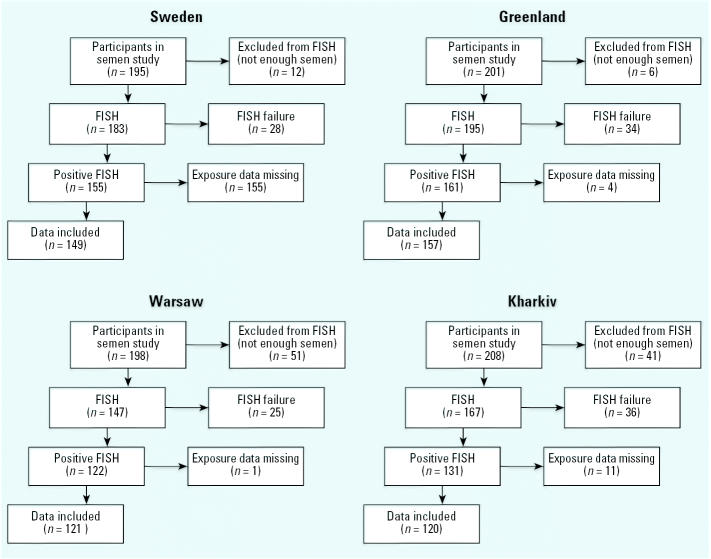
Flow chart for recruitment of participants in semen and FISH study.